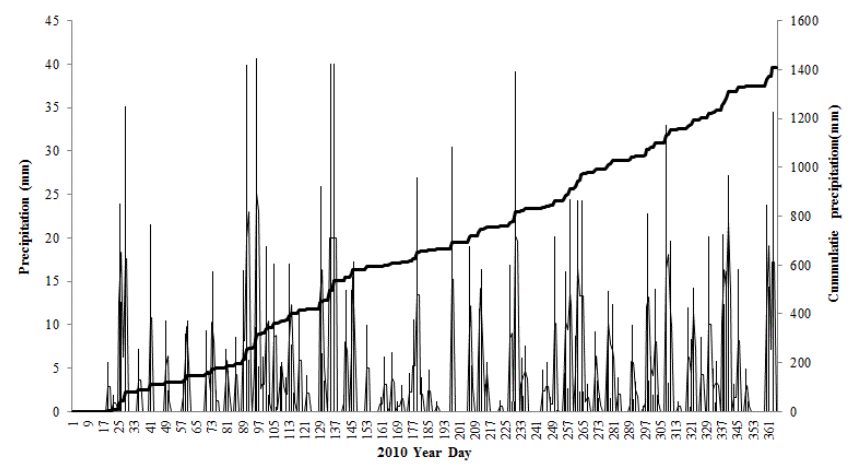
Figure 1. Daily and cumulative precipitation for 2010 in Kiboga district,